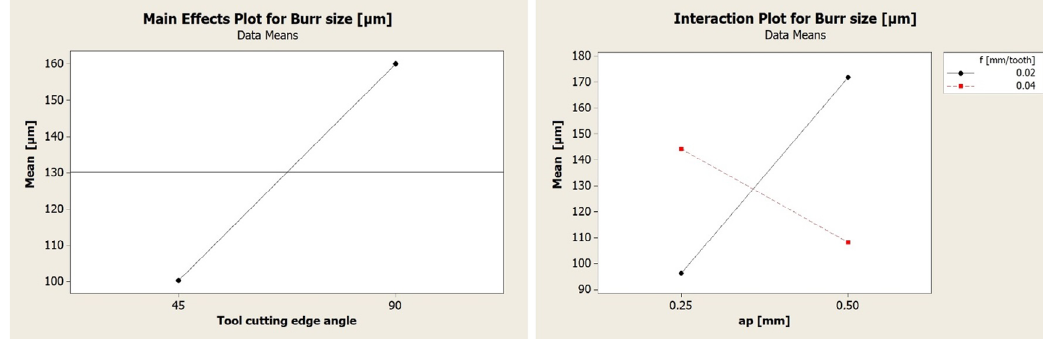
Figure 5. Main effects and interaction plots involving the determining factors for carbon fiber burrs